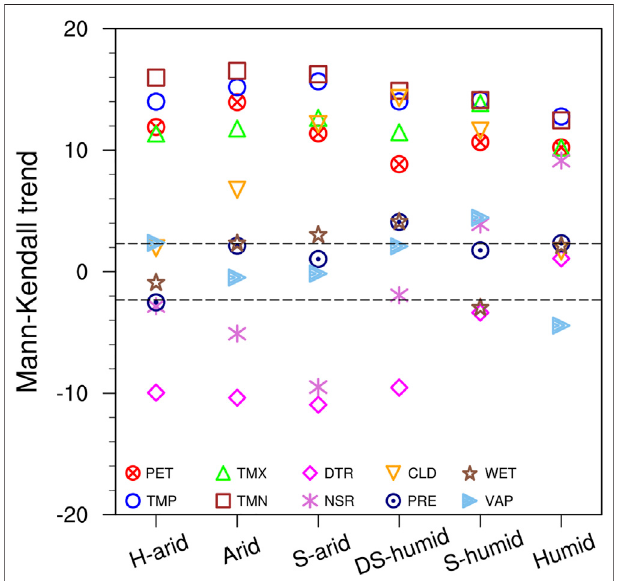
FIGURE 8 | Mann – Kendall trends in X-12-ARIMA trend components of in fl uencing factors in six climatic areas of China from 1982 to 2015. The local 99% con fi dence levels are about ± 2.32.